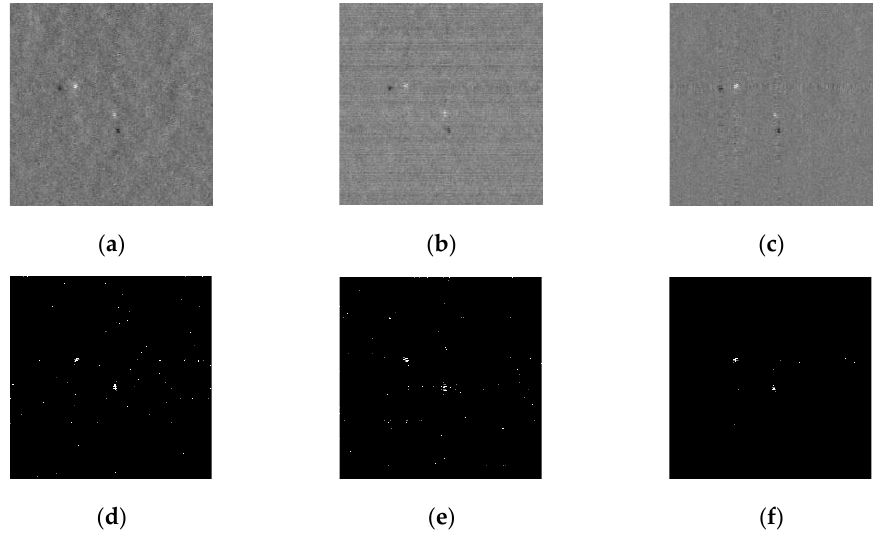
Figure 7. Comparison of algorithms of the recovered spatial domain image, and detection results: ( a ) Compressive subtracted image reconstructed by 2D SL0, ( b ) Compressive subtracted image reconstructed by 2D IAA, ( c ) Compressive subtracted image mapping by Part Hadamard, ( d ) Detection